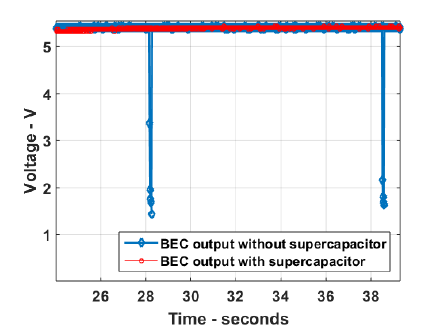
Figure 4. A snapshot of battery eliminator circuit (BEC) output voltage with/without the supercapacitor in parallel across it when the BEC is supplied by the fuel cell